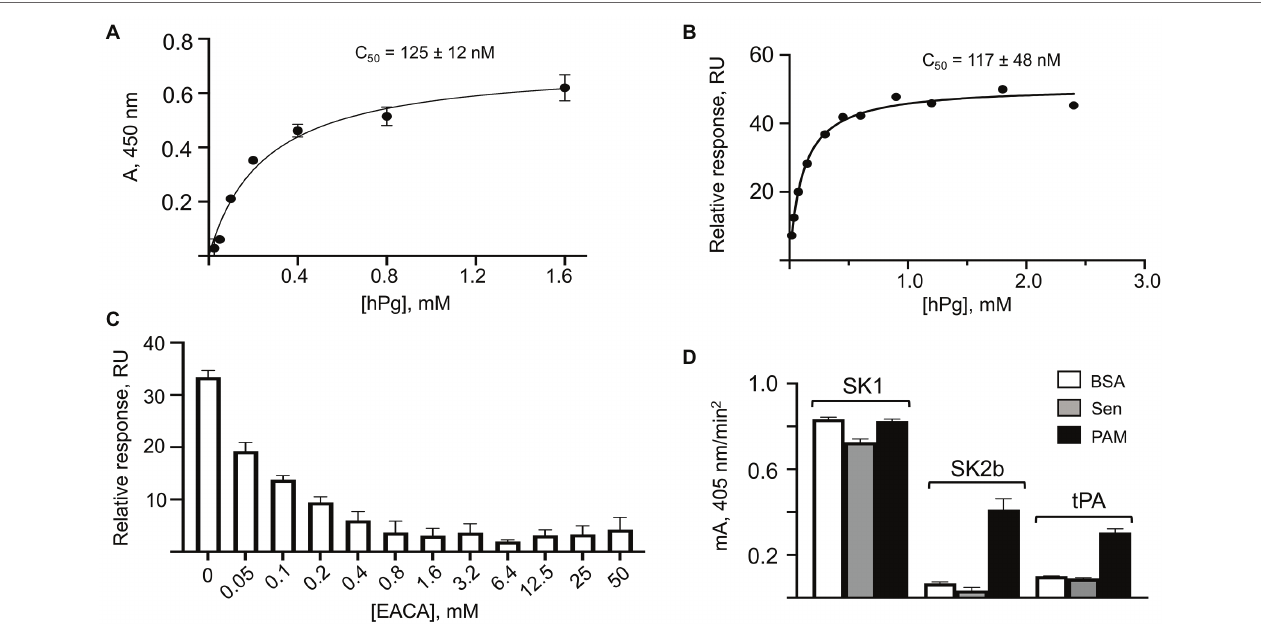
FIGURE 4 | Binding of hPg to Sen on surfaces. (A) Interaction of hPg with plate-bound Sen by ELISA. Sen was bound to individual wells of a 96-well high protein binding microtiter plates. Next, hPg was added, followed by HRP-anti-hPg. HRP activity was detected using the substrate, TMB/H 2 O 2 . The A 280 nm is plotted against [hPg], thereby allowing determination of the C50 from the fitted curve. The saturation curve and C 50 value for the binding of hPg to Sen were generated using GraphPad Prism 9.0. (B) Binding of hPg to chip-immobilized Sen by surface plasmon resonance (SPR). The response units (RU) as a function of hPg analyte concentrations were fit using the equilibrium method allowing the determination of the C 50 of binding. (C) e-aminocaproic acid (EACA) competition for the binding of hPg to Sen by SPR. Sen was bound to the chip and hPg (1 μ M) analyte in the presence of the indicated EACA concentrations was flowed through the chip surface. The RU vs. [EACA] is shown in the plot. (D) Stimulation of the activation of hPg by Sen. Multiple wells of a high protein binding microtiter plate were coated overnight with Sen, PAM, or BSA. hPg was added to the wells and activation of hPg was initiated by addition of catalytic levels of SK1, SK2b, or tPA, each mixed with the chromogenic substrate, S2251 (H-D-Val-Leu-Lys-pNA). The release of p-nitroaniline from S2251 was continuously monitored for 120 min at A 405nm. The initial rates of activation were obtained from the linear regions of the A 405nm vs. time plots and shown as the mA 405nm /min 2